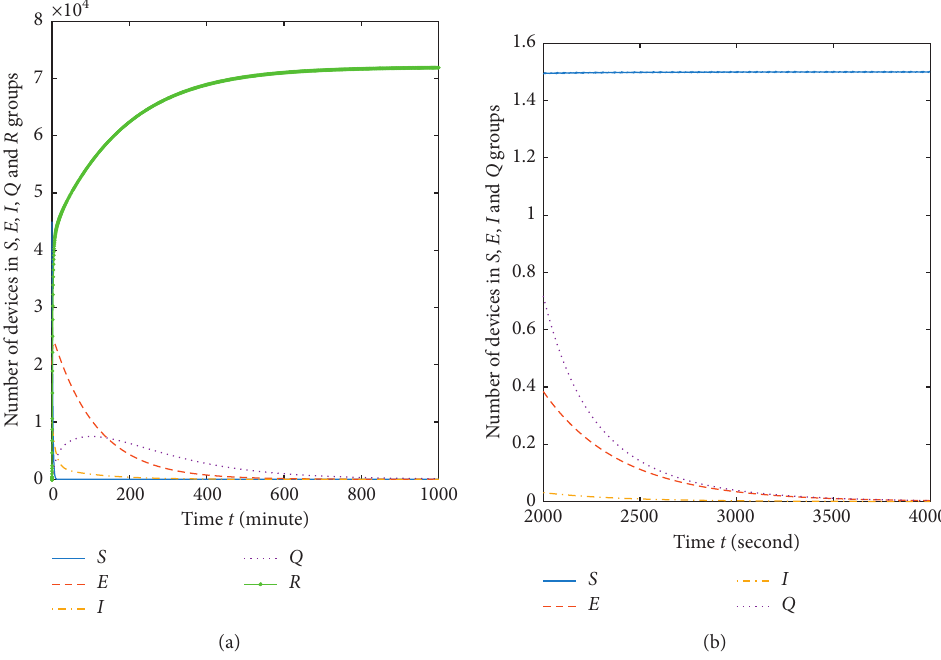
Figure 3: Dynamics of the worm-free equilibrium.